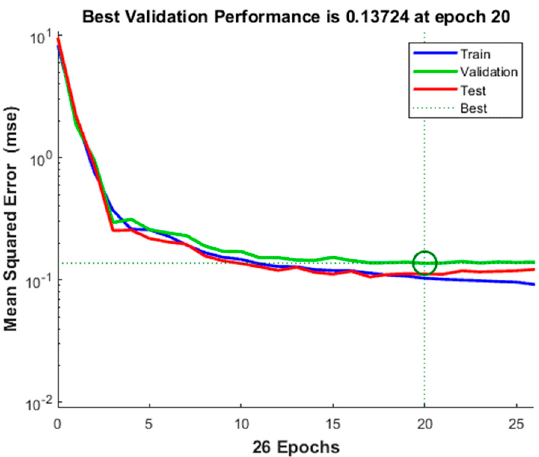
Figure 15. Mean square error training results of training set, validation set, and test set.